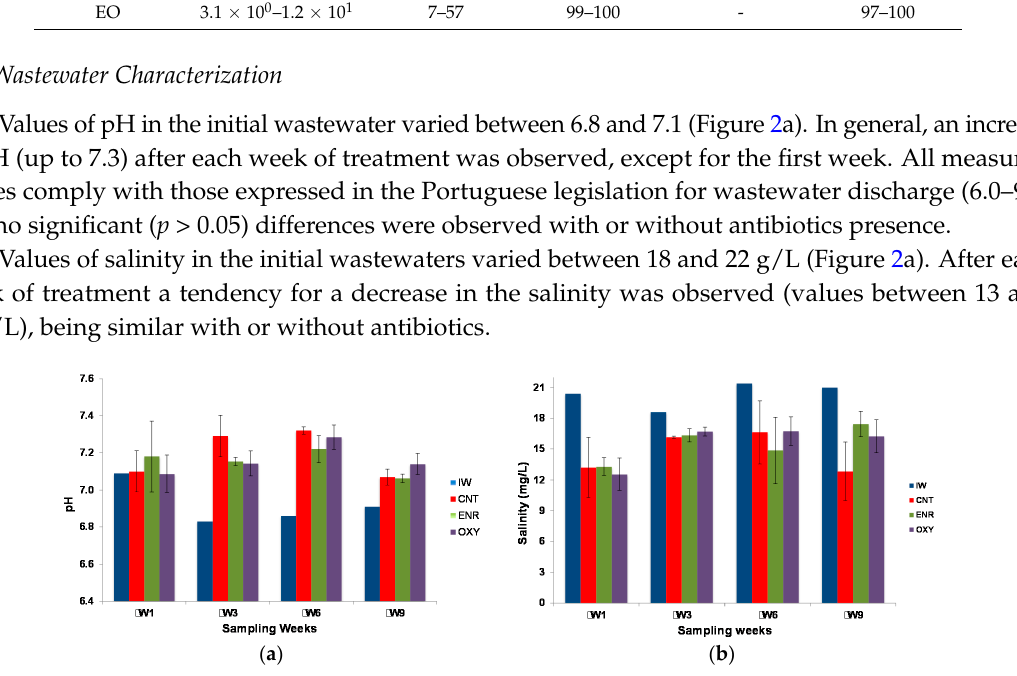
Table 1. Bacterial density (CFUs/mL) of the different bacterial taxonomic and antibiotic resistance groups in initial wastewater and bacterial removal percentages in CWs treated wastewater along the experiment in the different CWs microcosms. Wastewater not doped (CNT) or doped with the antibiotic enrofloxacin (ENR) or oxytetracycline (OXY). HT—Heterotrophic Total; HE—Heterotrophic resistant to ENR; HO—Heterotrophic resistant to OXY; CT—Coliforms Total; CE—Coliforms resistant to ENR; CO—Coliforms resistant to OXY; ET—Enterococcus Total; EE—Enterococcus resistant to ENR; EO—Enterococcus resistant to OXY. Initial Wastewater Bacterial Taxonomic